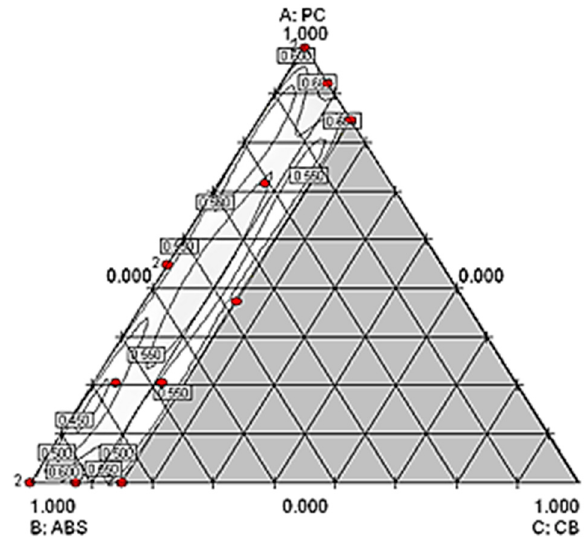
Figure 2. Mixture design. Table 1. Percentage of the composition of polycarbonate (PC)/ acrylonitrile–butadiene–styrene (ABS) and carbon black (CB).